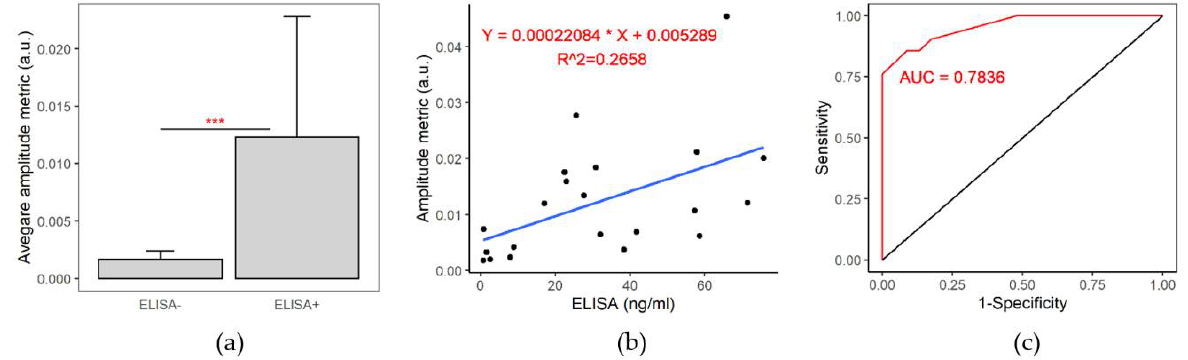
Figure 5. ( a ) A bar diagram showing average IgM amplitude metrics between the ELISA− and ELISA+ samples. The average IgM amplitude matrices of the ELISA+ samples is significantly higher than that if ELISA- samples (*** indicates p ≤ 0.001). ( b ) A linear regression plot between the IgM amplitude metric and ELISA for IgM. ( c ) A ROC curve that shows the performance of our device for detecting ELISA− and ELISA+ IgM samples.